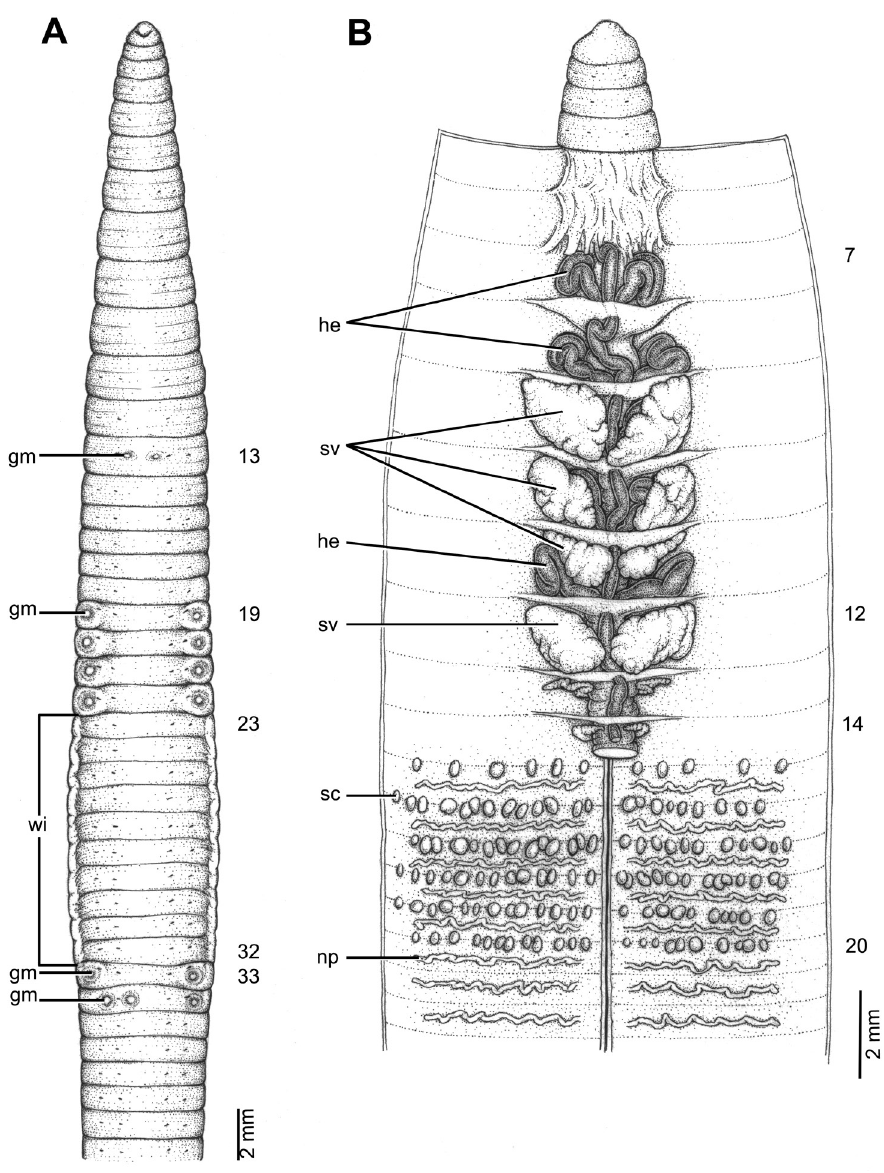
Figure 12. Morphology of holotype (CUMZ 3426) of Glyphidrilus champasakensis sp. n. A external ventral view, annular clitellum in XIX–XLIX B internal dorsal